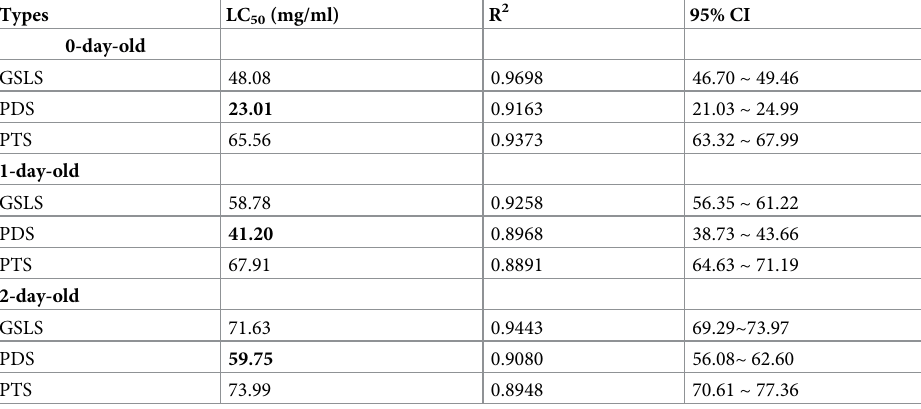
Table 2. Regression analysis for ovicidal activity of